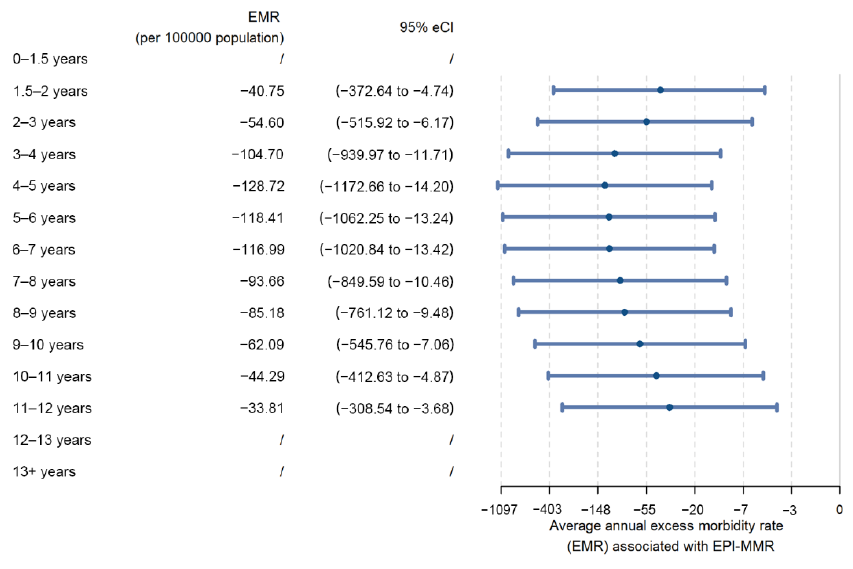
Figure 2. Excess risks of mumps incidence attributable to the EPI-MMR intervention in Guangzhou, China. The shadow represents the 95% confidence intervals of excess risks.